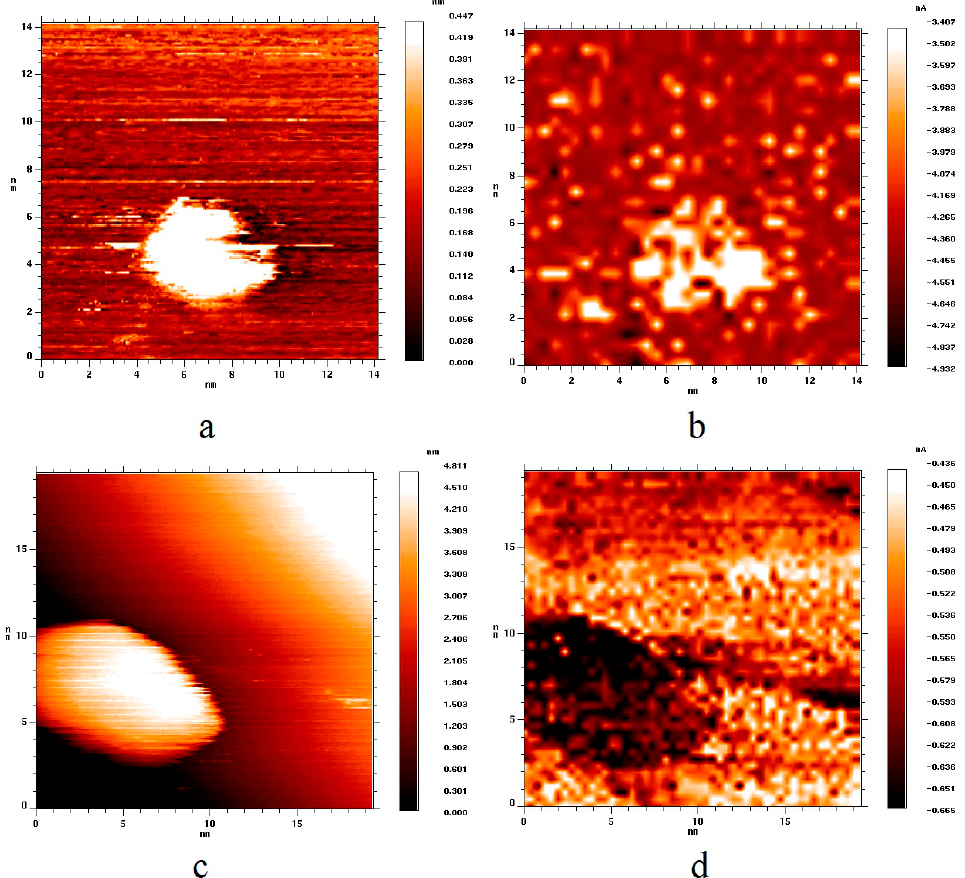
Figure 4. ( a , c ) Topography images of two HOPG surface areas with deposited gold nanoparticles of various sizes after their exposure to molecular hydrogen; ( b , d ) current images of the same surface areas. ( a , b ) U bias = 2.0 V, I tunnel = 3.1 nA; ( c , d ) U bias = 2.1 V, I tunnel = 3.1 nA.